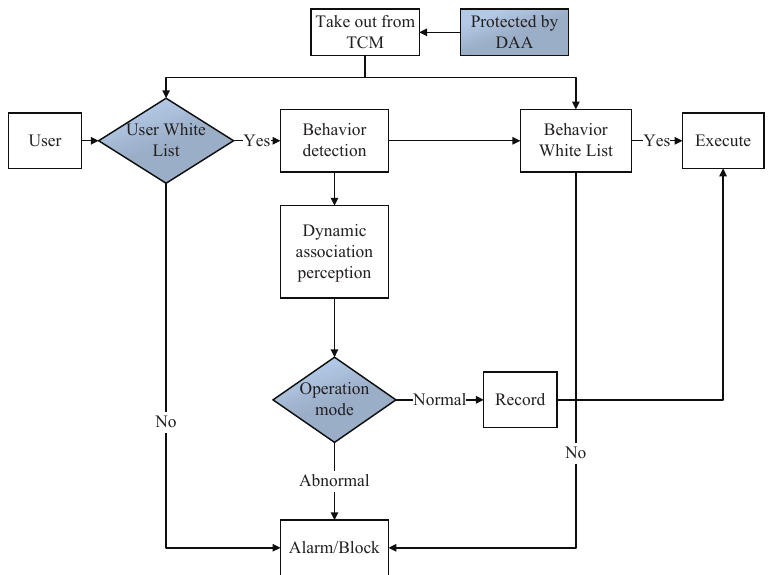
Figure 6. Trusted computing remote attestation and